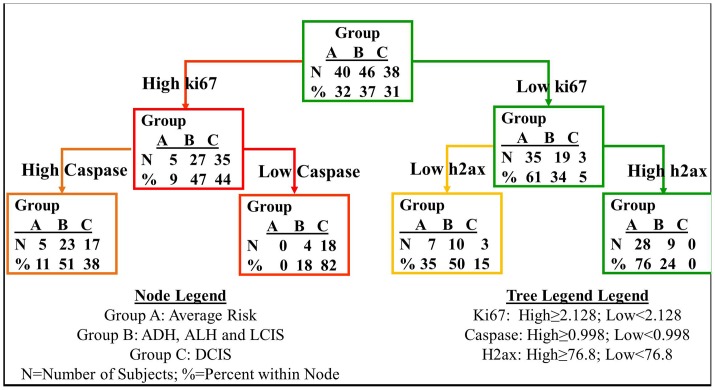
DNA damage in breast cancer risk and progression (a) Tree modeling showing predictability power of combination of several biomarkers for invasive breast cancer risk.Note that starting node in the tree model is fewer number than the total given for each risk cohort (40, 46 and 38). This reflects cases that were removed because all three biomarkers- Ki67, γ-H2AX and Caspase-3 -were not evaluable. Although this resulted in a smaller subset, this was necessary to better identify the distinct combination of the biomarkers by growing the tree based on completed data for all biomarkers of interest.